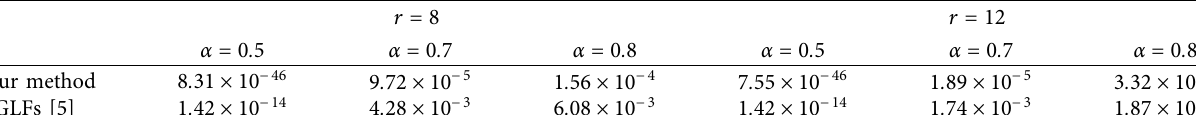
Table 3: The maximum of absolute value error taking different values for r and α for Example 2.